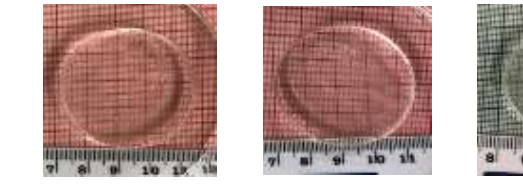
Figure 8. The appearances of the disc samples of S5 at the following times: 0 h, 6 h, 72 h, 216 h, 336 h, and 384 h.